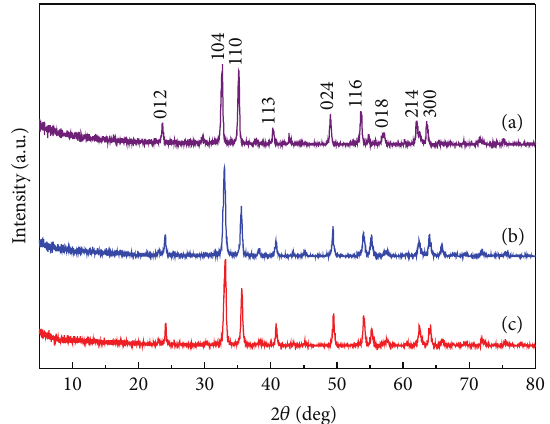
Figure 2: XRD patterns of the iron oxide samples. (a) FO-0, (b) FO- 1, and (c) FO-2.